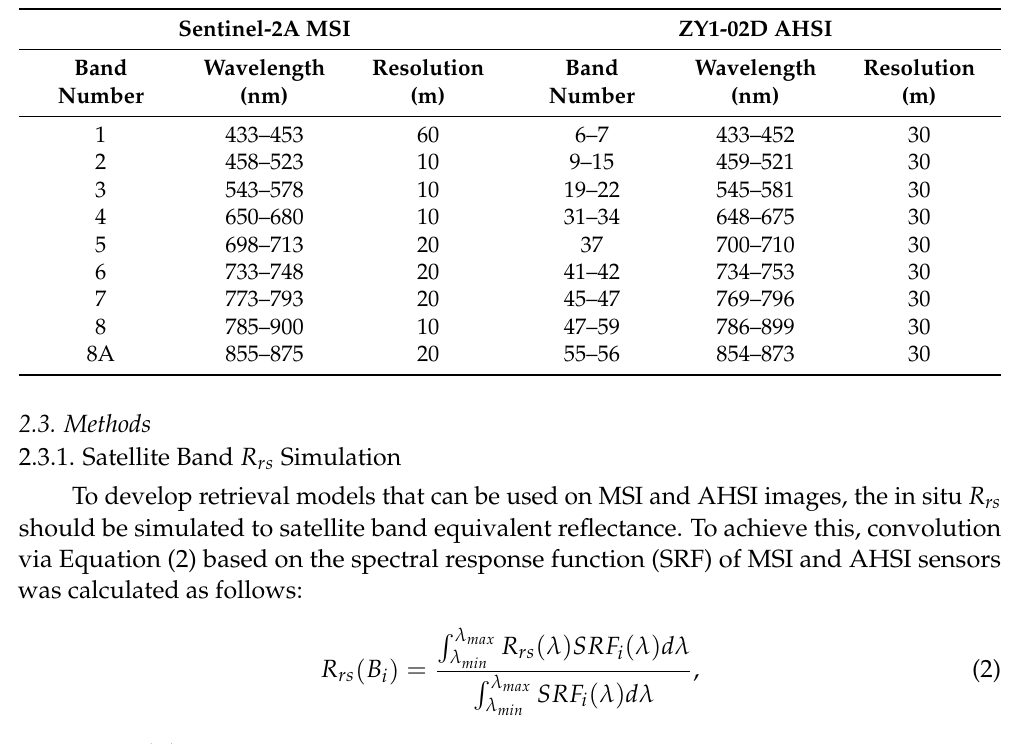
Table 3. Band number, wavelength, and resolution of the MSI and AHSI used in this study.